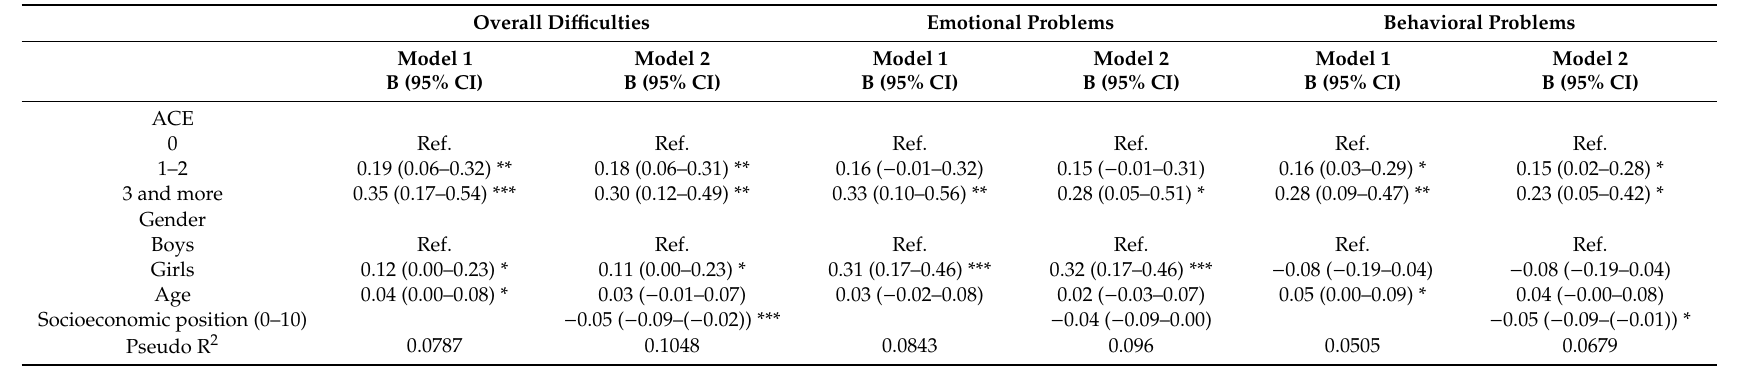
Table 2. Associations between the number of adverse childhood experiences (ACE) and emotional and behavioral problems, overall and separately adjusted for gender, age (Model 1), and socioeconomic position (Model 2) from generalized linear models (B coe ffi cients / 95% Wald confidence intervals) (Slovakia 2017, 10–16 years old, n =